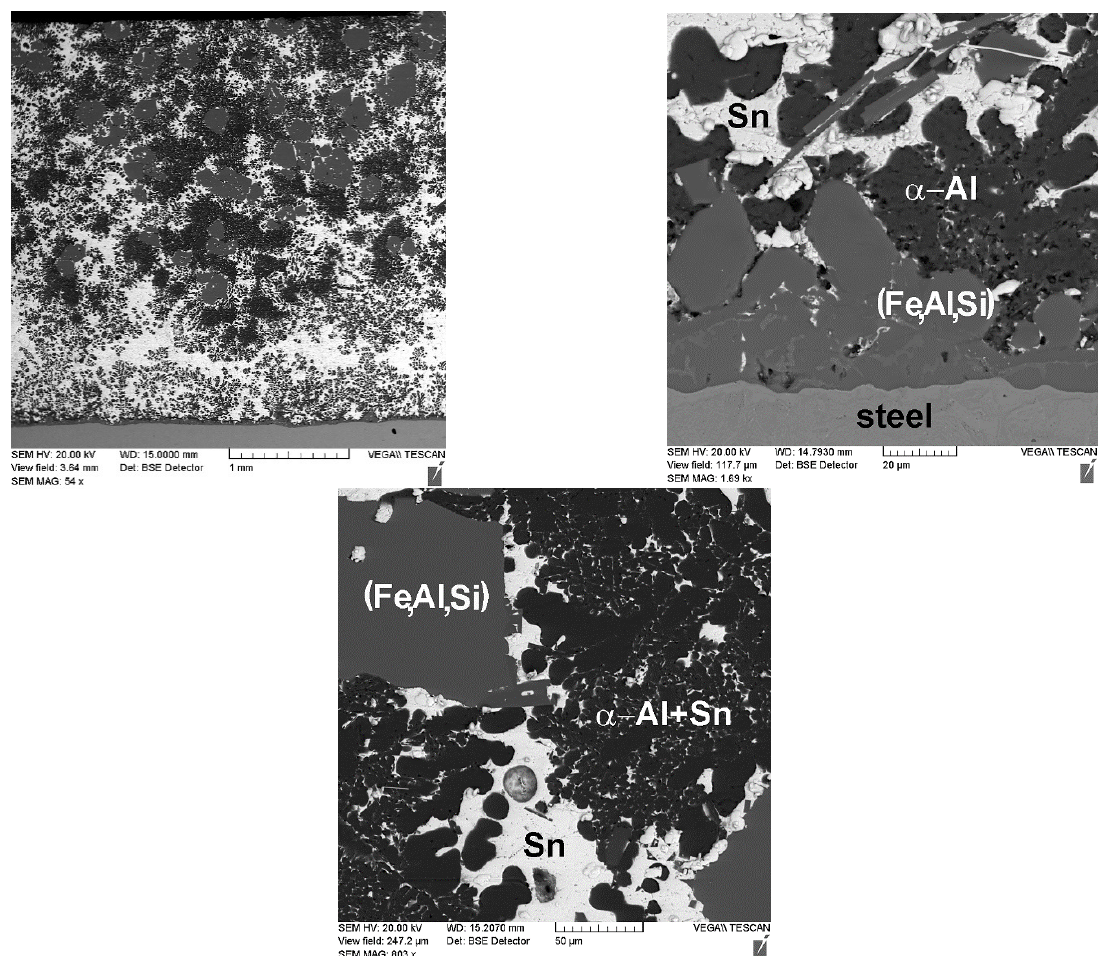
Figure 7. The microstructure of the deposited layer from the AlSi12 alloy with the tin addition.